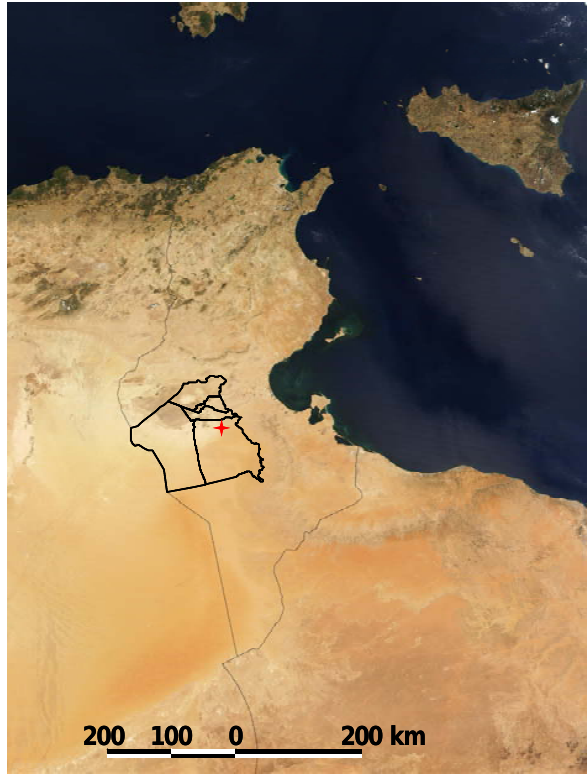
Fig. 3. MODIS satellite view of Tunisia with indications of national borders (credit: Jacques Decloitres, NASA/GSFC/Land Rapid Re- sponse Team) and districts of the Governorate of Kebili (bold line). The soil collection location (33 ◦ 27.7 0 N, 9 ◦ 20.8 0 E) is marked by the red star in the district of Douz, SW of the Chott El Djerid (darker area) and at the NE margin of the Great Eastern Erg.